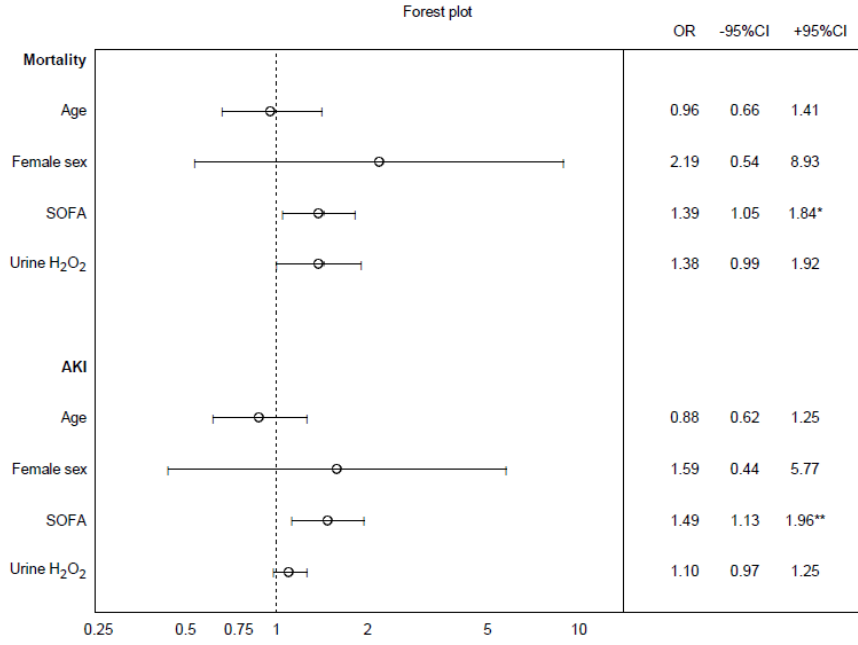
Figure 4. Forest plot. Odds ratios for univariable logistic regression. Age has the unit of decades and H 2 O 2 has the unit 10 µmol/L to optimize presentation in the figure. Odds ratio ± 95% confidence interval ( CI). * p < 0.05, ** p < 0.01.